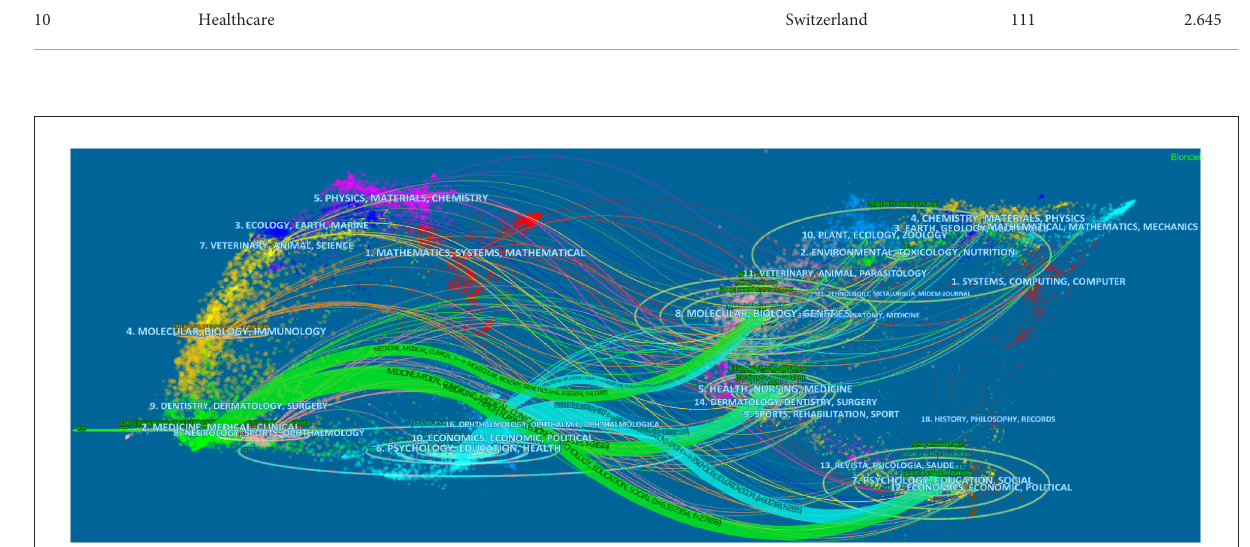
FIGURE1 The dual-map overlay of journals on mental health research related to